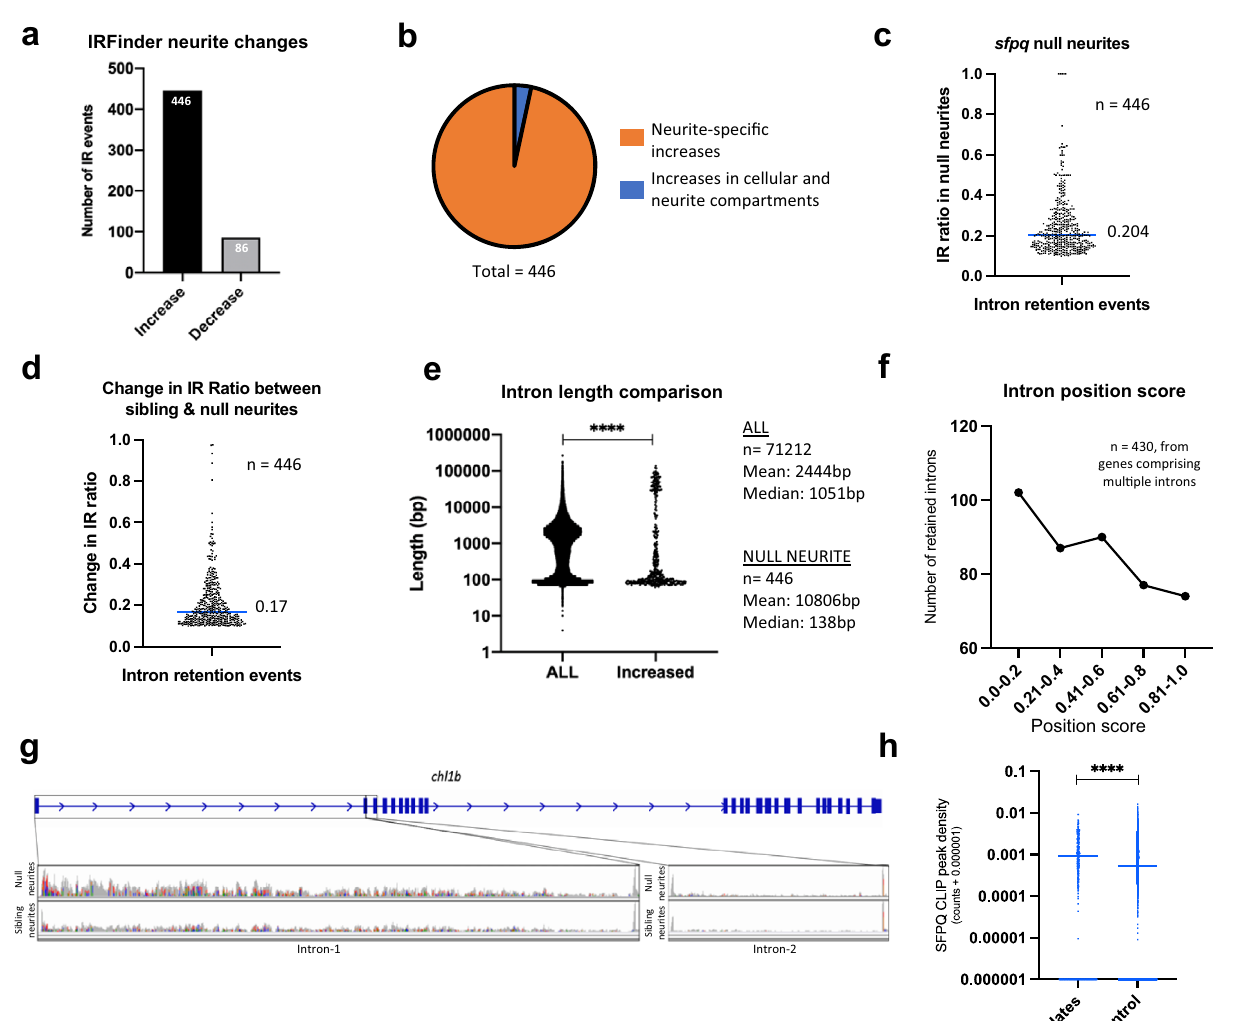
Fig. 2 | Loss of SFPQ modi fi es distribution of neurite-speci fi c retained introns. a Number of intron retention increases and decreases observed in null neurites identi fi ed in IR Finder (>0.1 change in IR Ratio, Audic & Claverie test, p <0.05) ( b ) Proportionofintronretentionincreasesthatareneurite-speci fi c(changeinneurite IR Ratio is >0.05 above that in the cellular compartment). 15 intron retention events(blueslice)increasesimilarlyinboththeneuriteandcellularcompartments. c Proportionoftranscriptsforeachofthe446genesin( a )thatareintron-retaining innullneurites.MedianIRratio=0.204(i.e.~20%ofalltranscriptsofagivengene). d Change in IR ratiofrom sibling neurites to null neurites (medianincrease=0.17).